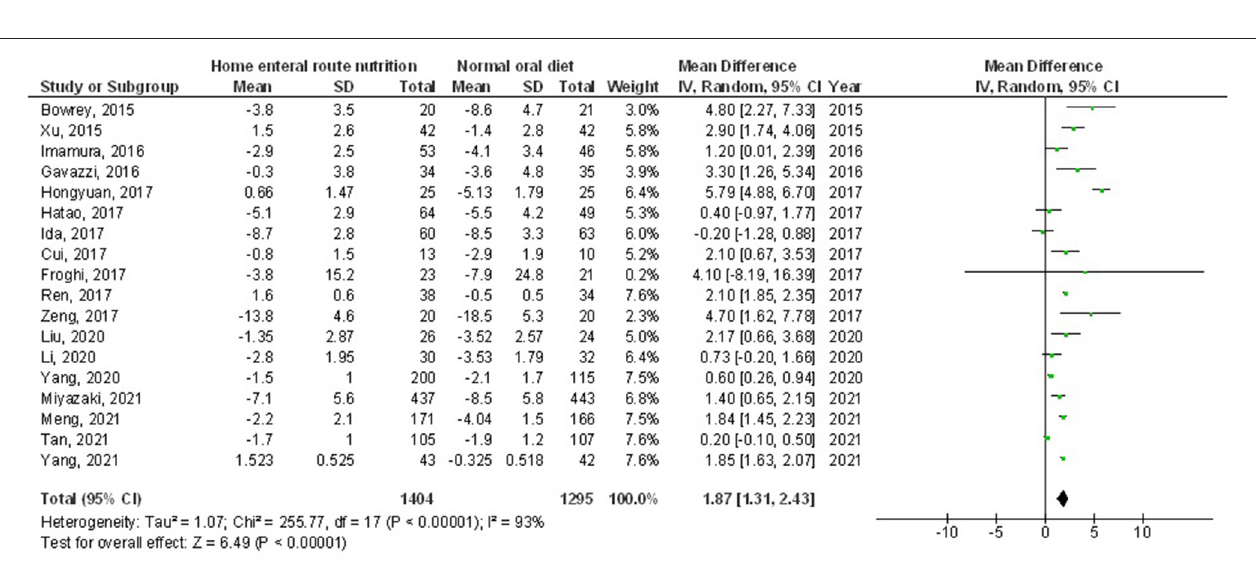
FIGURE 3 | A forest plot of the bodyweight change in subjects with upper gastrointestinal cancer resection with the home enteral nutritional support compared to the normal oral diet.